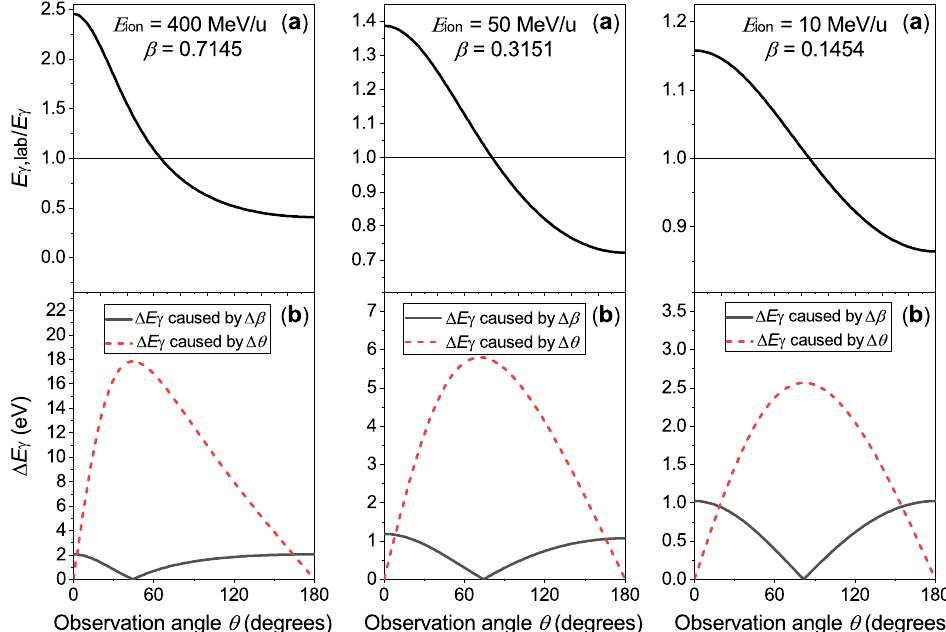
Figure 1. ( a ) Relativistic Doppler shift and ( b ) uncertainty of the Doppler correction of a transition with E γ ,emit = 100 keV photon energy in the emitter system: The contributions caused by uncertain- ties of the ion beam velocity ∆ β (black line) and the observation angle ∆ θ (red dotted line) are plotted separately. See text for